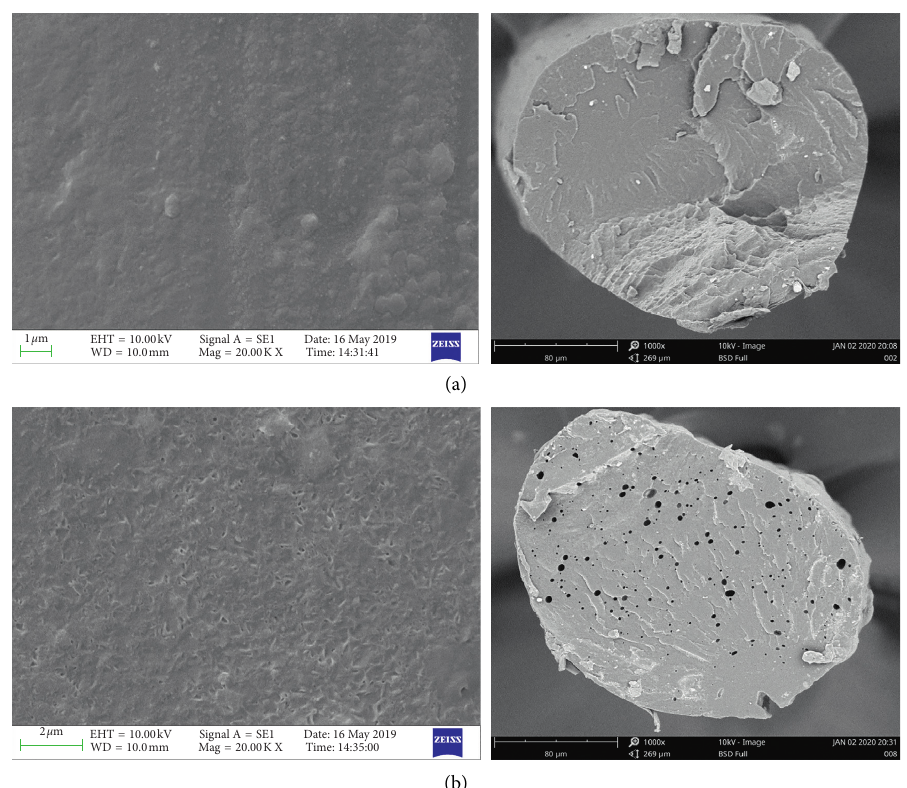
Figure 3: Surface and cross-section SEM images of modified fiber with 11.81% porosity and pure PA fiber.(a) Pure PA fiber. (b) Modified